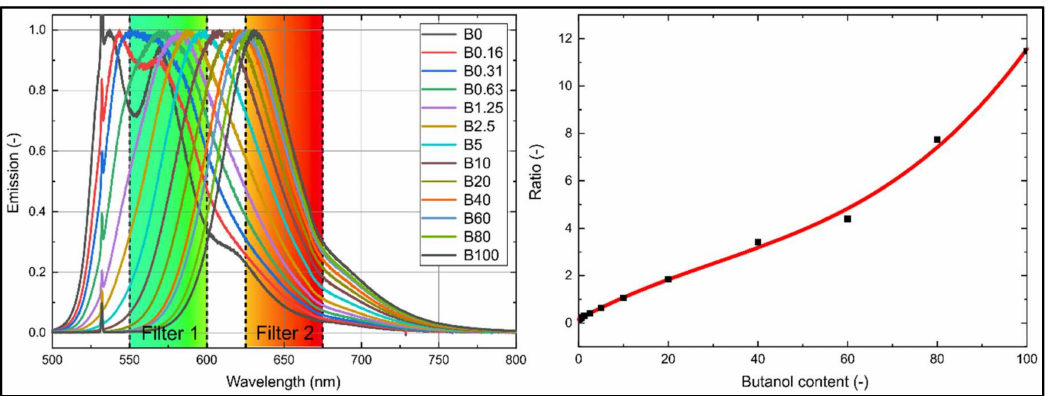
Figure8. Normalizedemissionspectraofnilered(7.5mg / L)inn-decaneatvariousbutanolconcentrations and an overlay of suitable filters ( left ); intensity ratio ( right , R 2 = 0.997); 293 K, 0.1